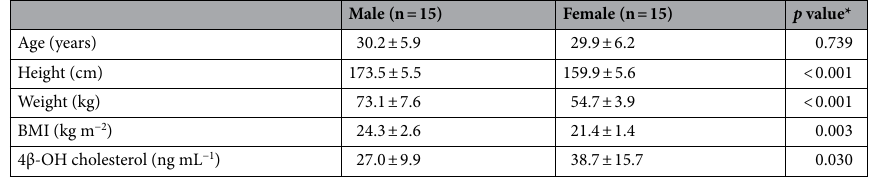
Table 1. Demographic characteristics. All values are presented as arithmetic mean ± standard deviation. * p value: calculated by Wilcoxon rank-sum test. BMI body mass